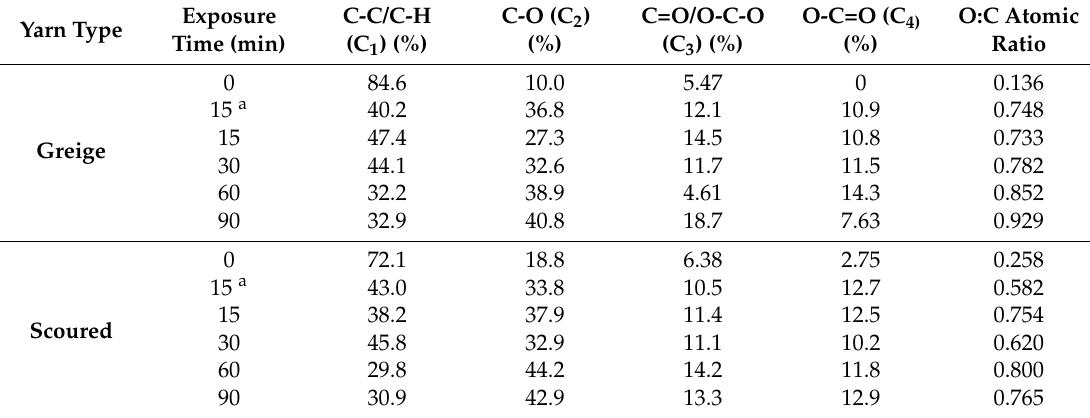
Table 2. X-ray Photoelectron Spectroscopy (XPS) C1s deconvoluted peak percent areas (C 1 , C 2 , C 3 , and C 4 ) and the O1s and C1s atomic % ratio for greige and scoured yarns treated at 0.46 W/cm 2 power